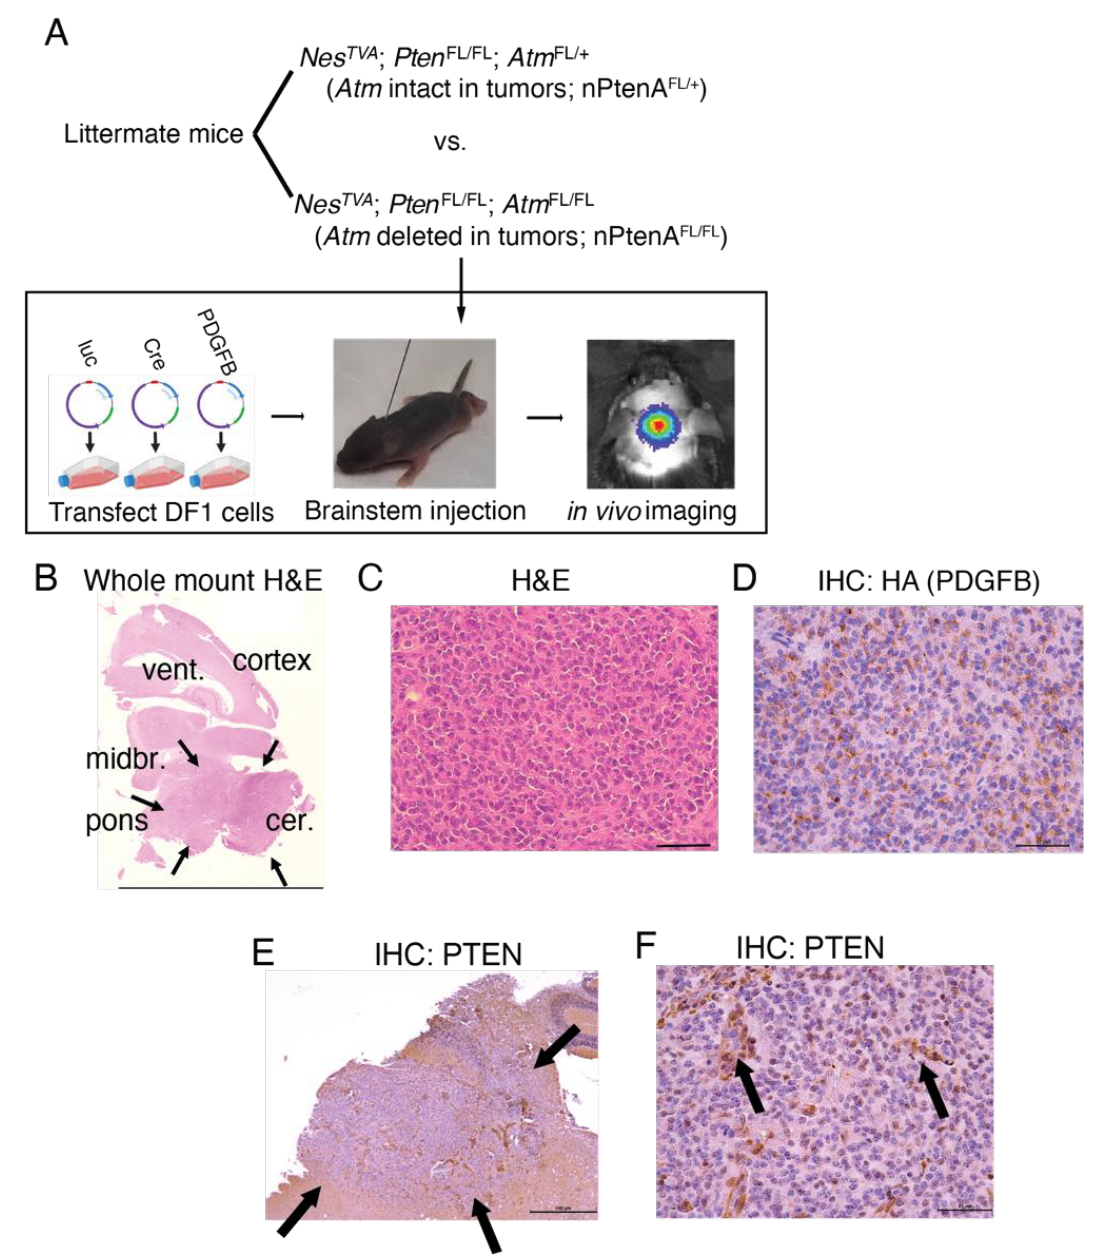
Figure 1. Primary brainstem gliomas lacking Pten . ( A ) Genotypes of mice used in this manuscript, and schematic showing workflow of generating retroviral RCAS vectors carrying Cre, luc, and PDGFB-HA payloads in chicken DF1 cells, injection of DF1 cells into the mouse brainstem, and then monitoring for tumor formation with in vivo bioluminescence imaging. ( B ) Whole-mount HE slide showing expansile tumors in the brainstem of nPtenA FL/FL mice. Midbr., midbrain; vent, lateral ventricle; cer., cerebellum. ( C ) Magnified HE slides for tumors from nPtenA FL/FL mice. Scale bar represents 50 µ m. ( D ) Immunohistochemistry staining for HA-tagged PDGFB in tumors from nPtenA FL/FL mice. Scale bar represents 50 µ m. ( E ) 5 × mount showing immunohistochemistry for PTEN of tumors centered in the brainstem (pons) with lack of PTEN reactivity, and diffuse infiltrating borders (arrows) for tumors from nPtenA FL/FL mice. Scale bar represents 500 µ m. ( F ) 40 × mount shows complete loss of PTEN in tumor cells but not normal blood vessels (arrows) in nPtenA FL/FL mice. Scale bar represents 50 µ